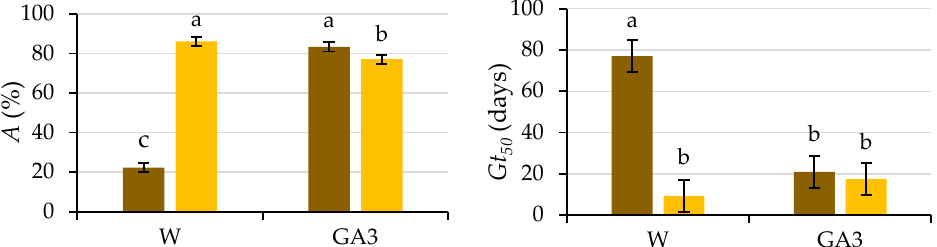
Figure 3. Logistic model adjusted to the germination curves made for seeds with intact testa (brown) and without testa (yellow) with substrate wetted with water (solid line) or GA 3 solution (500 mg L − 1 ; dashed line). Average values of four replicates.